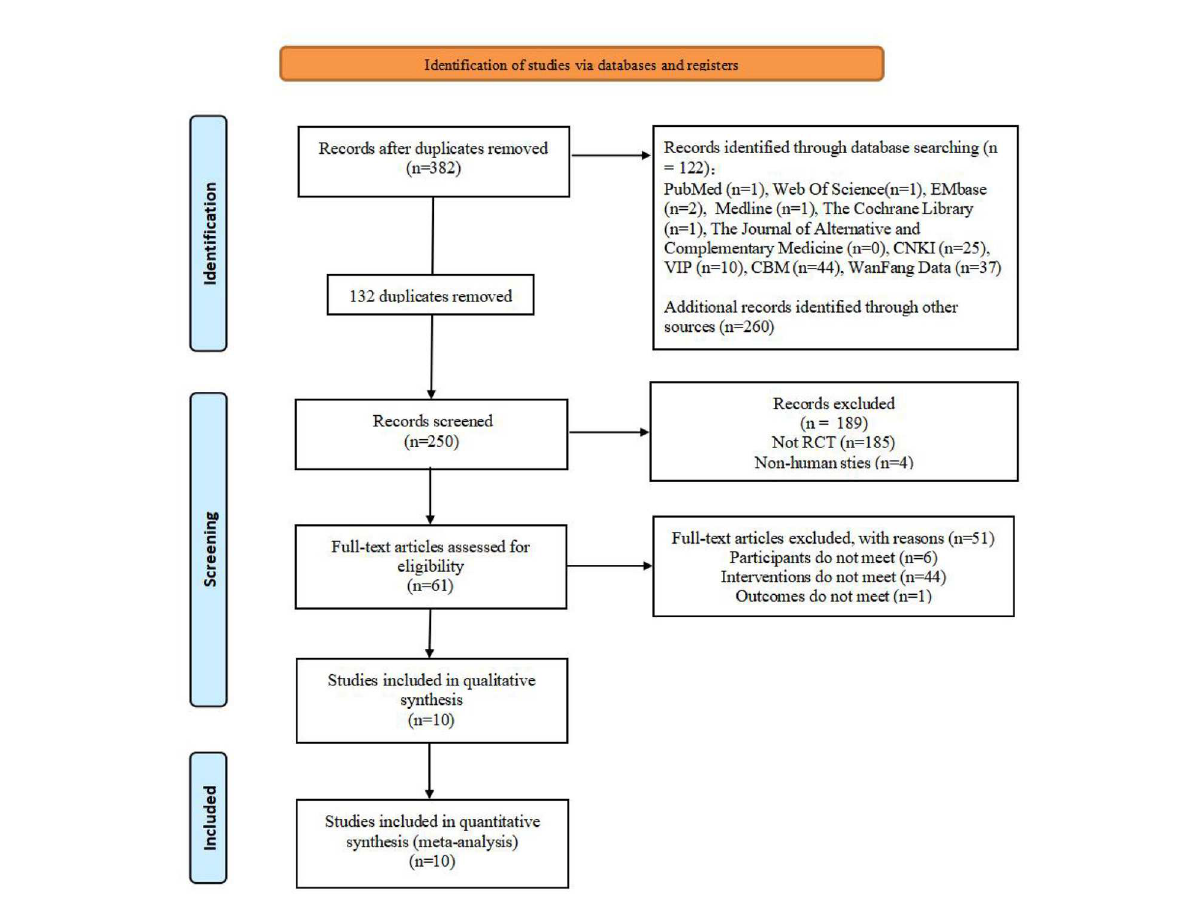
FIGURE2 PRISMA flowchart of the study selection process. RCT, randomized controlled trials; acupuncture combined with balloon dilation: Cricopharyngcal